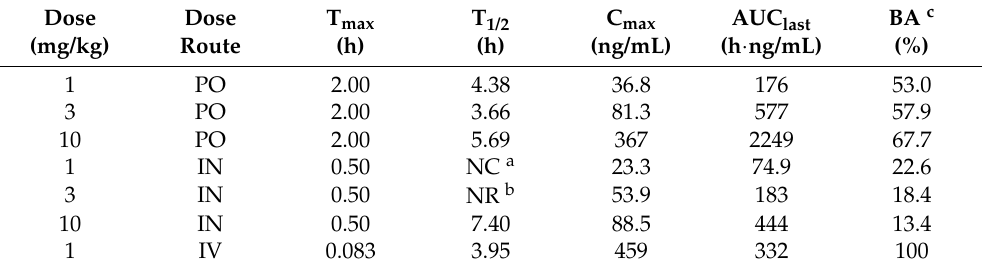
Table 4. Pharmacokinetic parameters and bioavailability of 11o in mouse